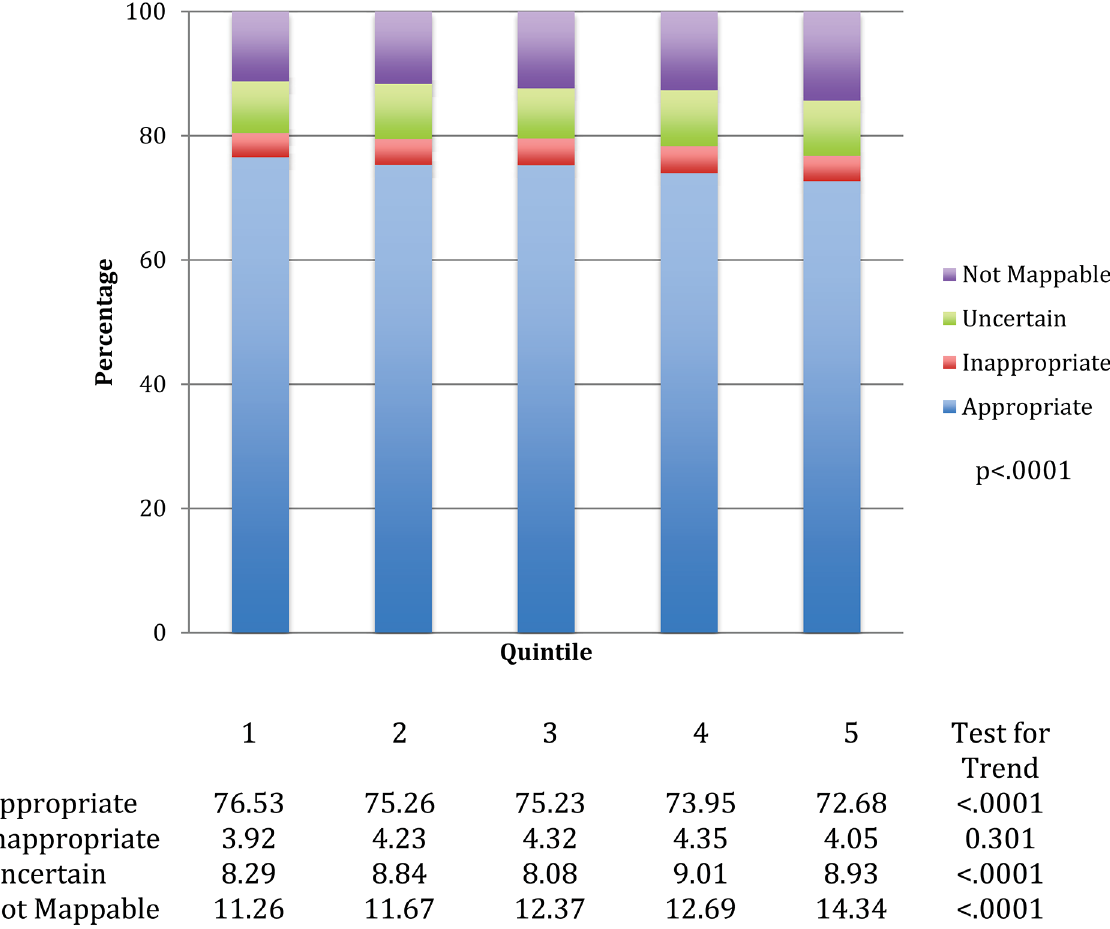
Fig 3. Distribution of PCI appropriateness across HRR quintiles for all PCIs. Shown is the application of the appropriate use criteria to quintiles of PCI utilization for all